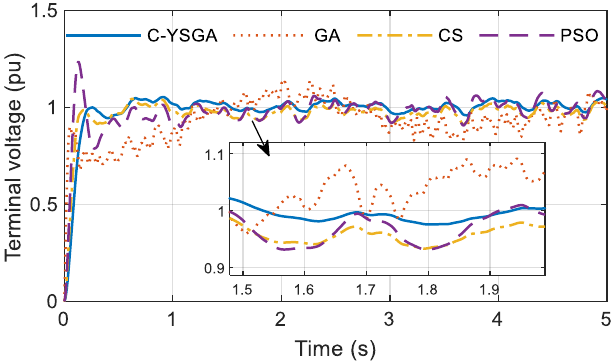
Figure 20. Step responses in the case of measurement noise.